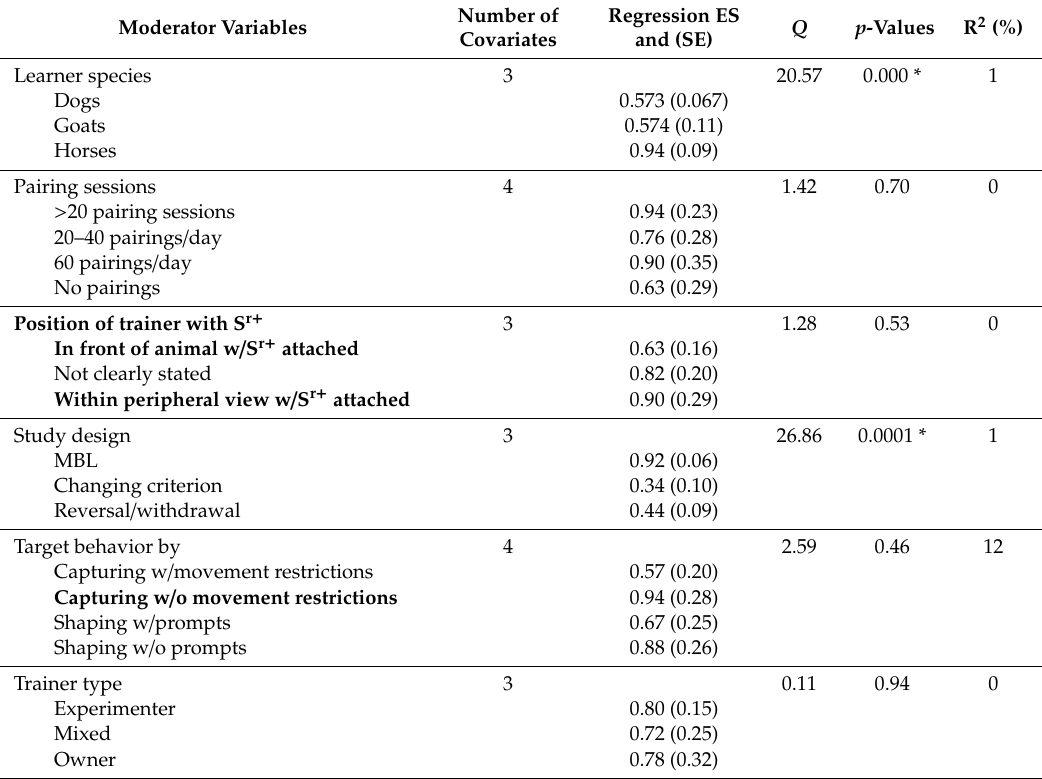
Table 10. E ff ect sizes and standard errors by potential